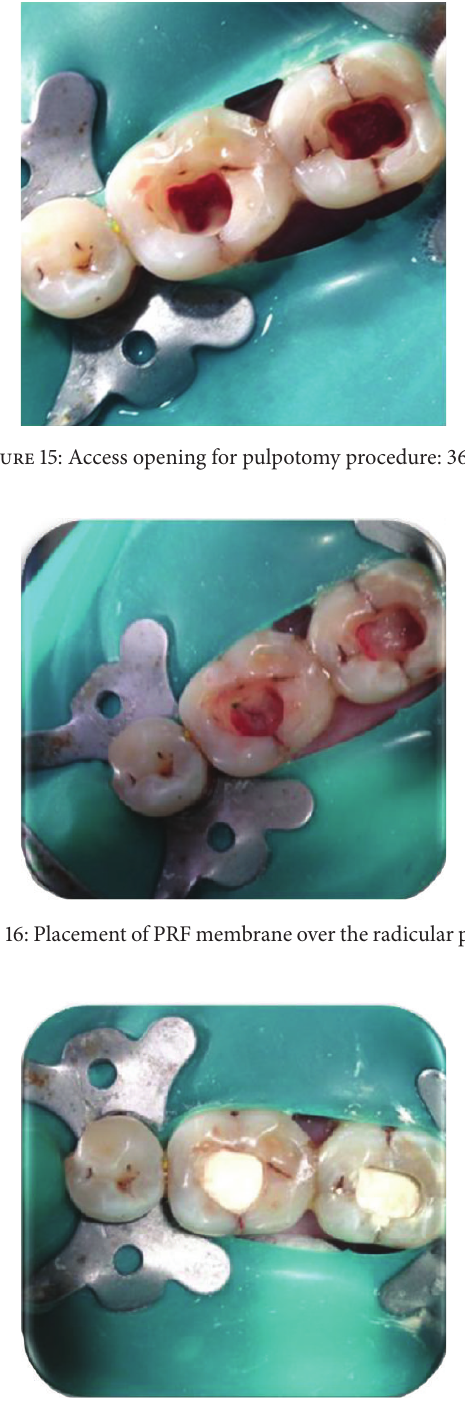
Figure 17: Placement of Biodentine over PRF: 36, 37.